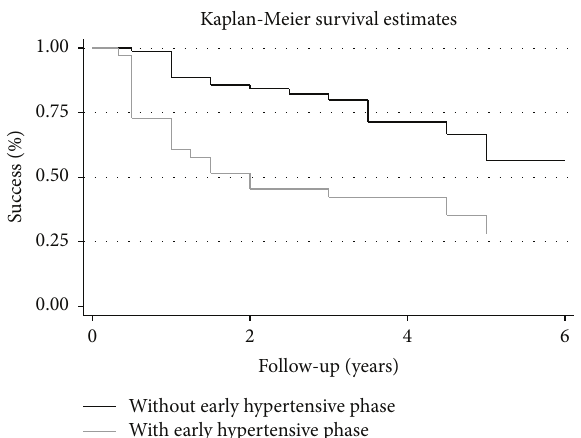
Figure 2: Percentage of success after Ahmed Glaucoma Valve implantation in patients with and without the occurrence of the earlyhypertensivephaseduringfollow-up,usingfailuredefinitionof intraocular pressure greater than 18mmHg and less than 5mmHg. Univariate analysis showed that early hypertensive phase was a risk factor for failure ( 𝑃 < 0.001